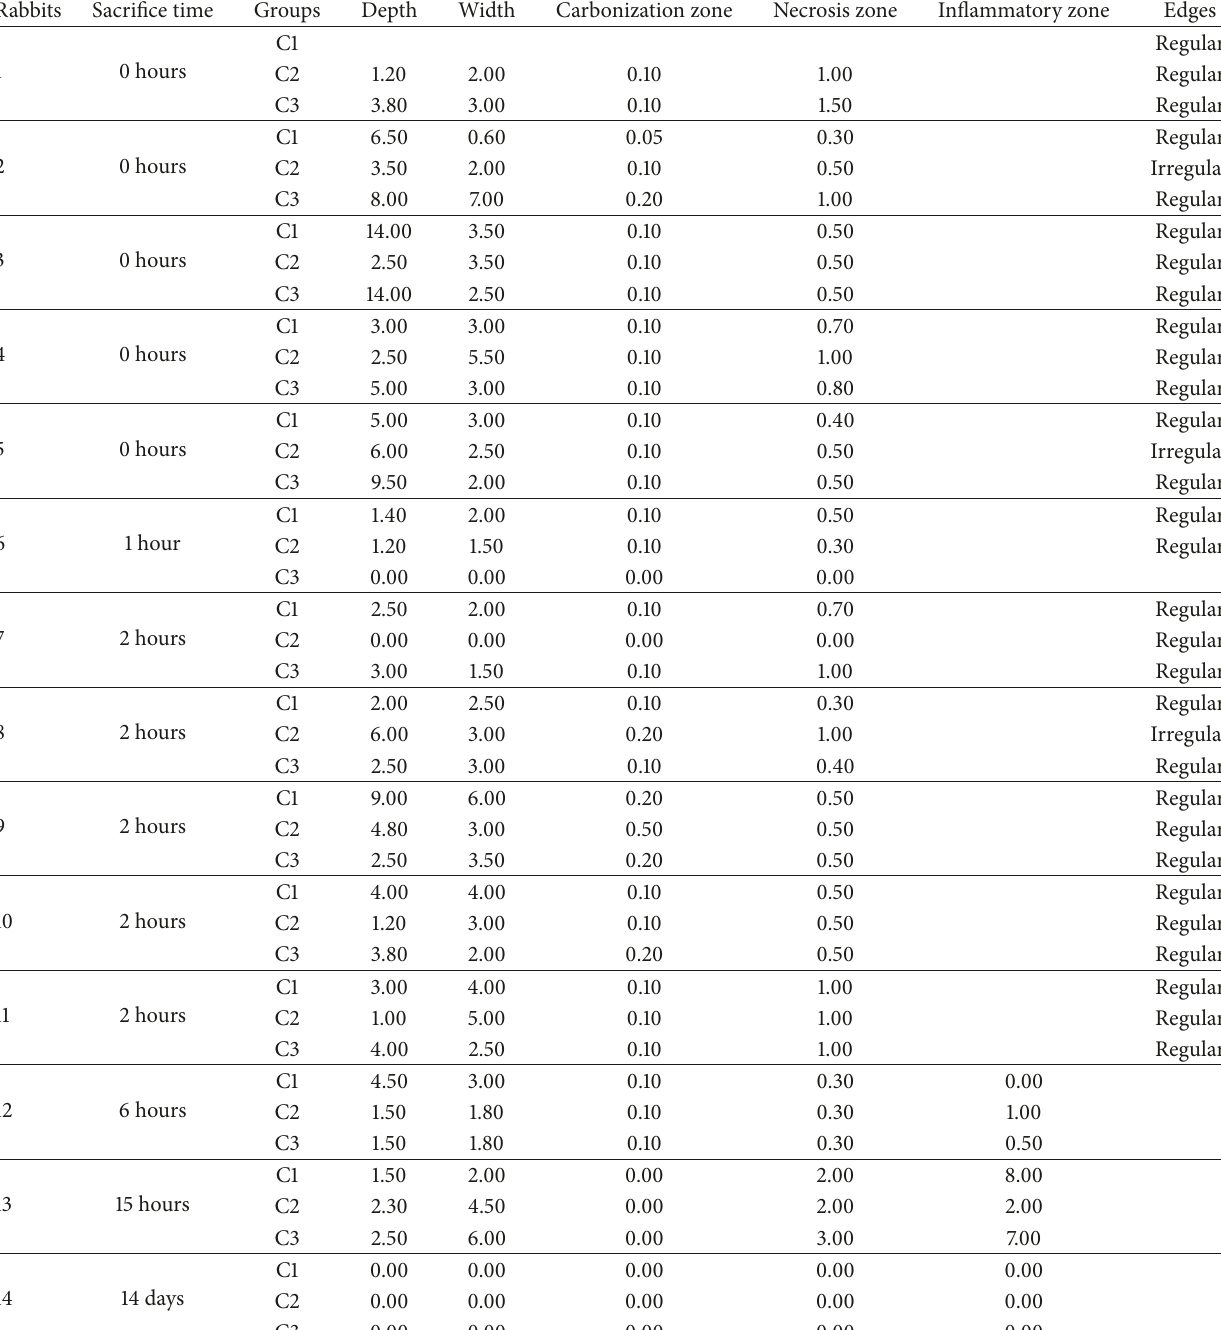
Table 1: Results of the fourteen rabbits concerning the depth and width of the incision, the carbonization, and necrotic and inflammatory zones.